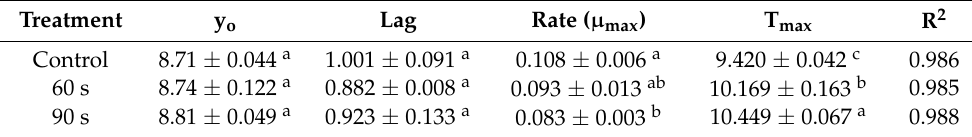
Table 3. Effect of sonication time on the kinetic growth parameters of Lactobacillus acidophilus (media ± standard deviation).